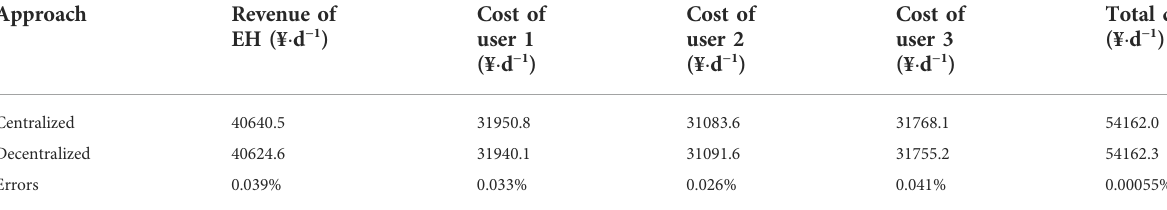
TABLE 3 The comparision of the results of centralized and decentralized